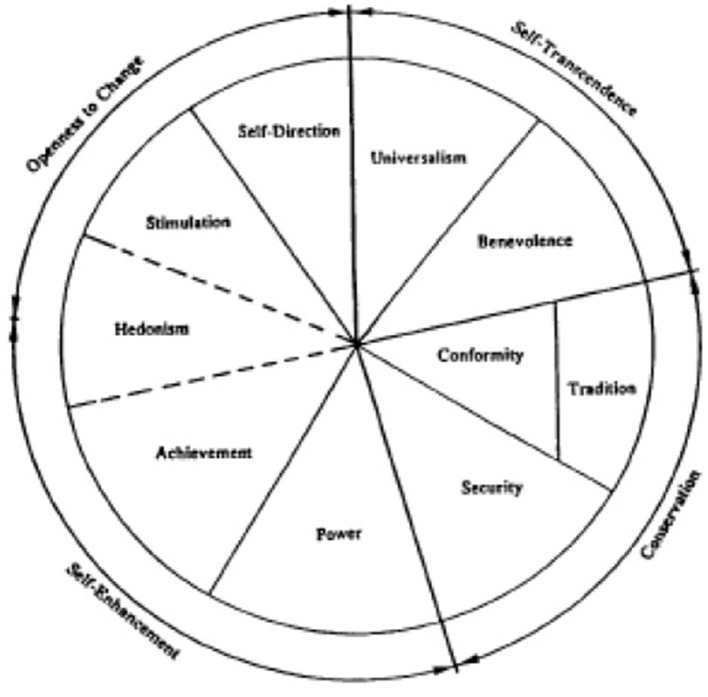
Schwartz's circumplex model of values (taken from Schwartz, 1994).